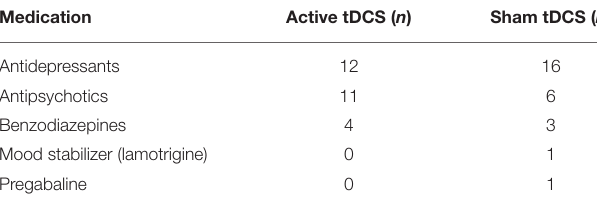
TABLE 3 | The concomitant